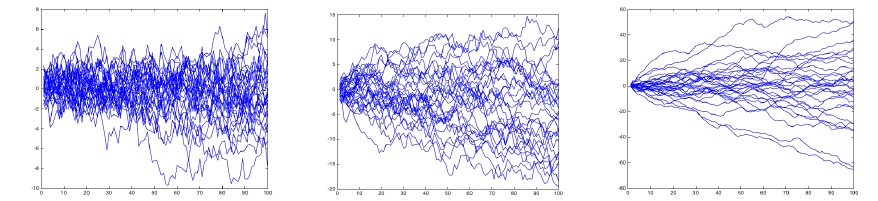
Figure 13. Population of 30 profiles generated by a fractional Brownian motion characterized by H = 0.25 ( left ), H = 0.5 ( center ) and H = 0.75 ( right ).